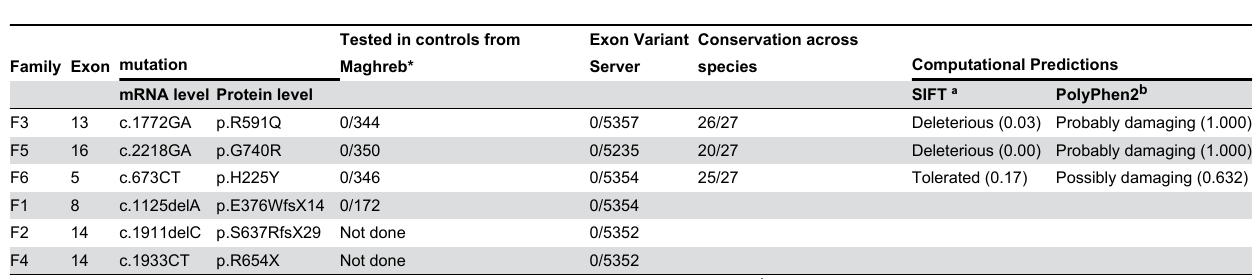
Not done 0/5352 The mutations were annotated according to the HGVS recommendations. In Bold, the reported mutation 4 . Prot. = protein. Score values are in brackets, they are between 0 and 1 for SIFT and PolyPhen2 software’s. * Results are reported in number of chromosomes. a SIFT score: the scores closer to 0 are the most deleterious. b Scores closer to 1 indicate that the mutation is damaging.